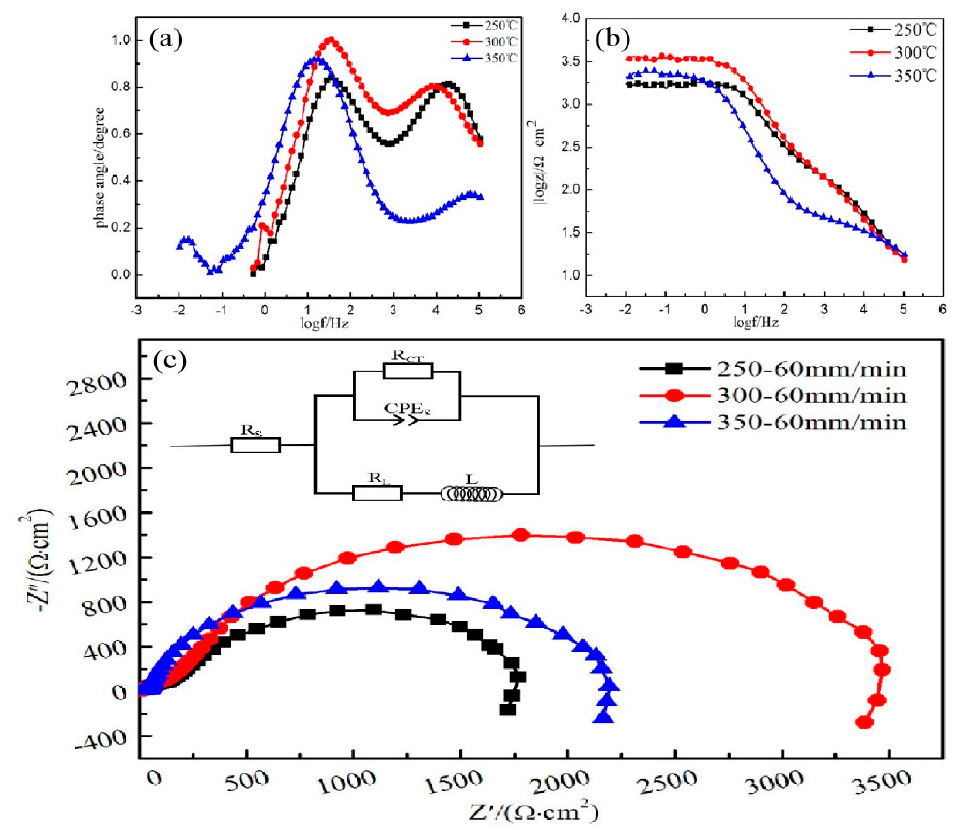
Figure 12. ( a ) Bode plots of phase angle versus frequency; ( b ) Bode plots of | z | vs. frequency, ( c ) Nyquist plots and equivalent circuits of the EIS spectra . Table 4. Fitting results obtained from the EIS spectra of extruded alloys.